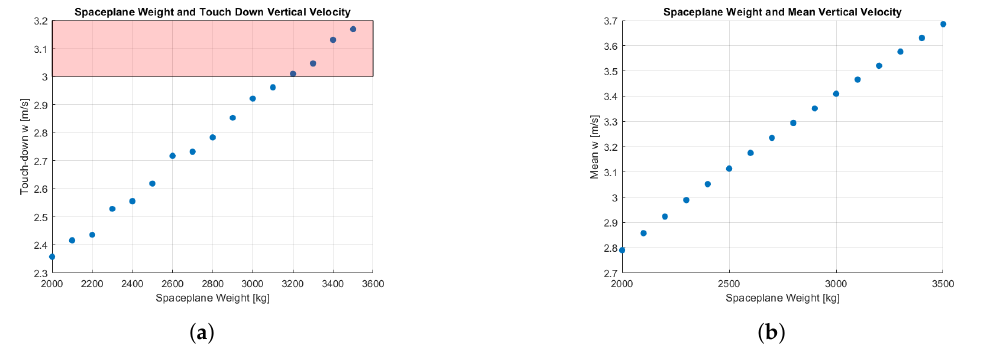
Figure 17. Touchdown vertical velocity for different payload weight for a parafoil of 280 m 2 surface and a control efficiency at 80%. The parameters are set as indicated in Table 2. ( a ) Touch-down vertical velocity; ( b ) mean vertical velocity.